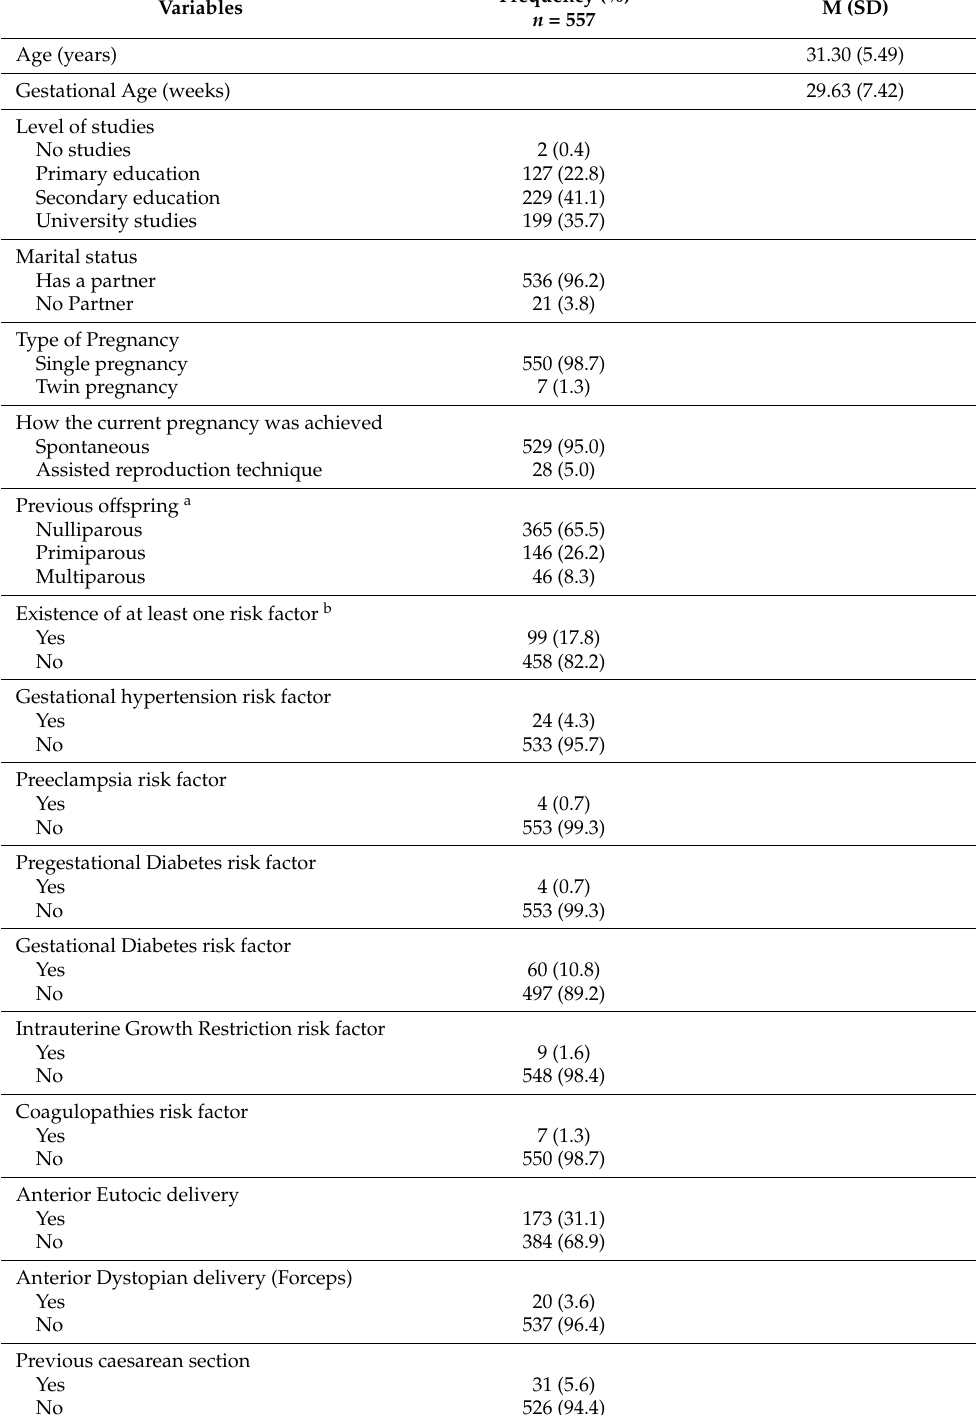
Table 1. Sociodemographic and obstetric variables of the sample ( n =